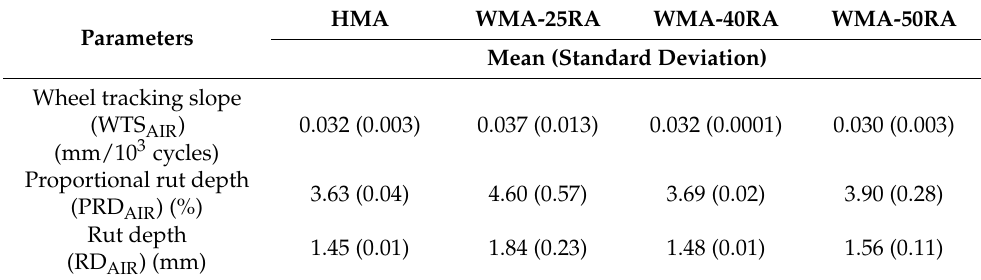
Figure 4. Wheel tracking test results. Table 2. Parameters from wheel tracking tests.